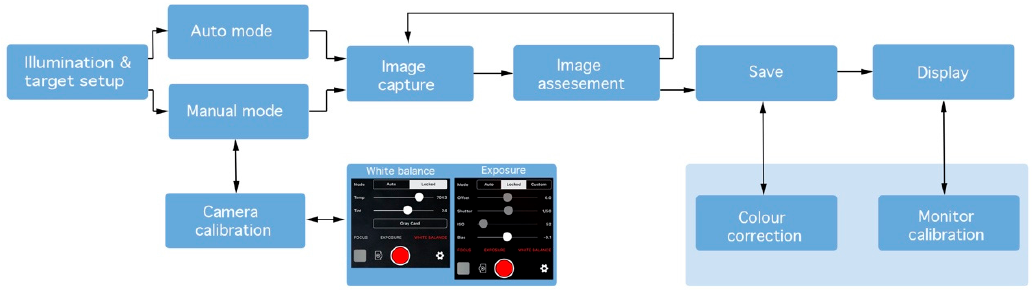
Figure 13. Algorithm for image capturing, assessing and displaying in automatic or manual camera mode.